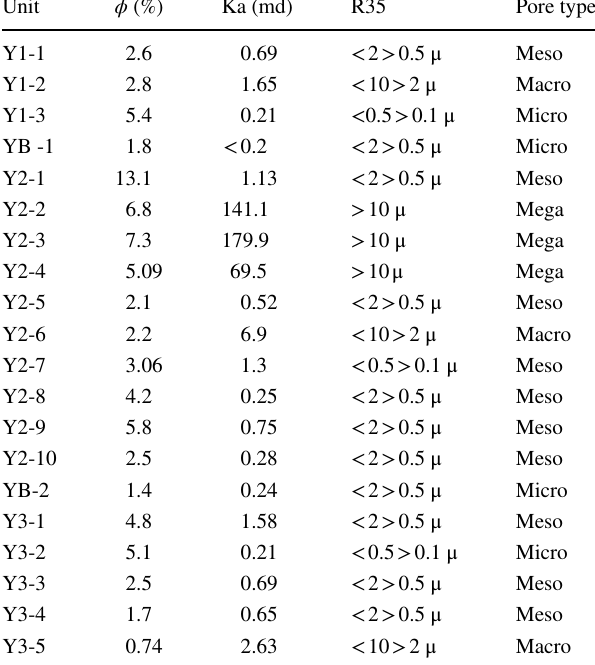
Table 2 Pore-throat size (R35) and pore type for well Rt-5